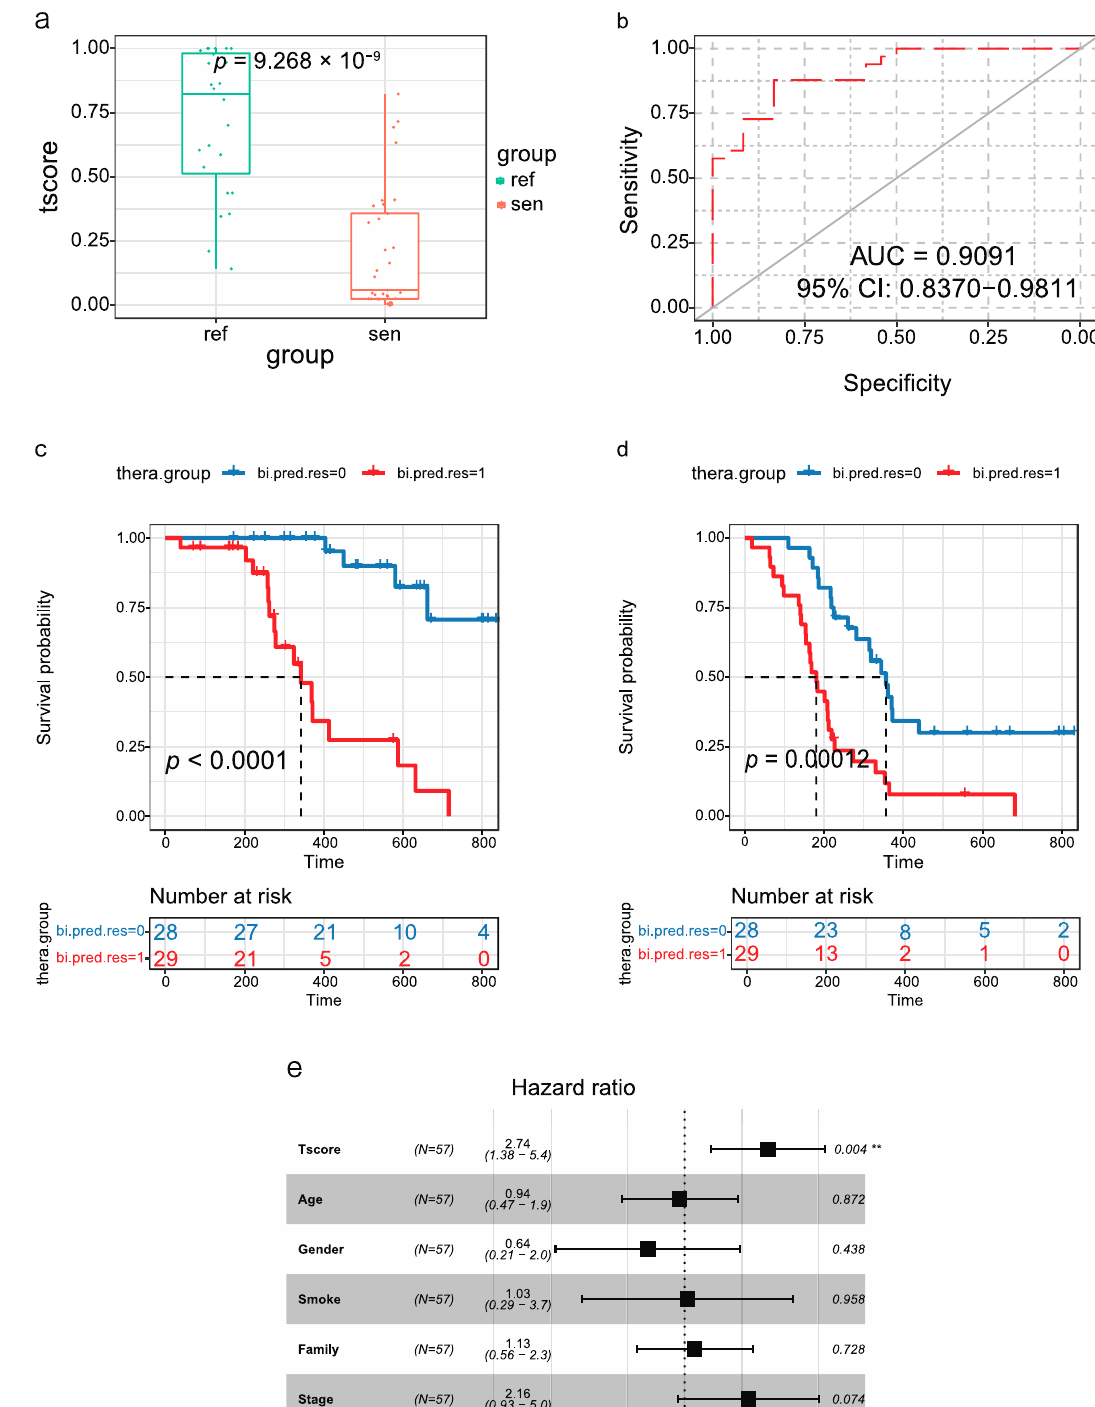
Figure 4. ExLR-based t-signature for the stratification of SCLC. ( a ) ExLR t-signature scores in chemo- sensitive ( N = 33) and chemo-refractory ( N = 24) groups. ( b ) ROC for the performance of the exLR t-signature in predictive chemotherapy treatment sensitivity of SCLC. ( c , d ) Kaplan–Meier survival analysis (log-rank test) of OS ( c ) and PFS ( d ) of SCLC patients with low ( n = 28) or high ( n = 29) t-scores. ( e ) Multivariate Cox proportional hazards regression analysis of clinical parameters and t-scores with PFS of SCLC patients. ROC: receiver operating characteristic.